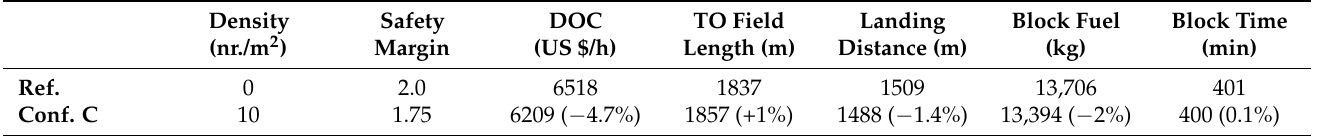
reference (without SHM and with SM =